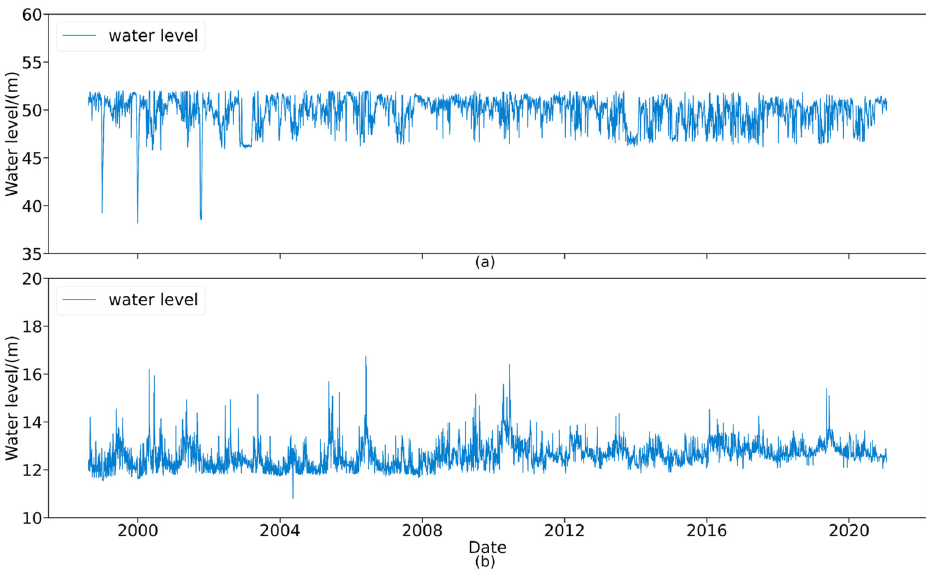
Figure 7. Water level data collected from automated monitoring equipment: ( a ) upstream water level and ( b ) downstream water level.